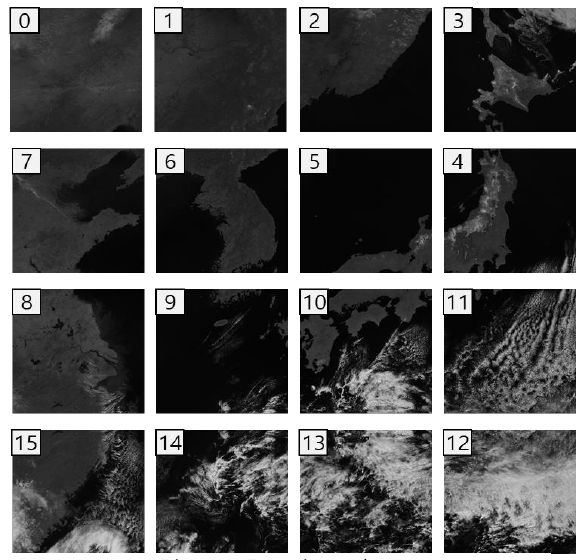
Figure 9. Experiment